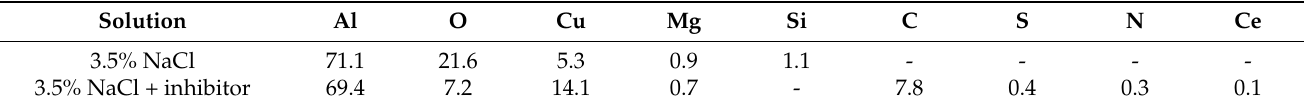
Figure 8. SEM images and EDS spectra of AA 2024-T3 alloy in ( a ) 3.5% NaCl and ( b ) 3.5% NaCl- containing inhibitor for 120 h. Table 3. The percentage of elements (atomic per cent) obtained from EDS spectra shown in Figure 8.